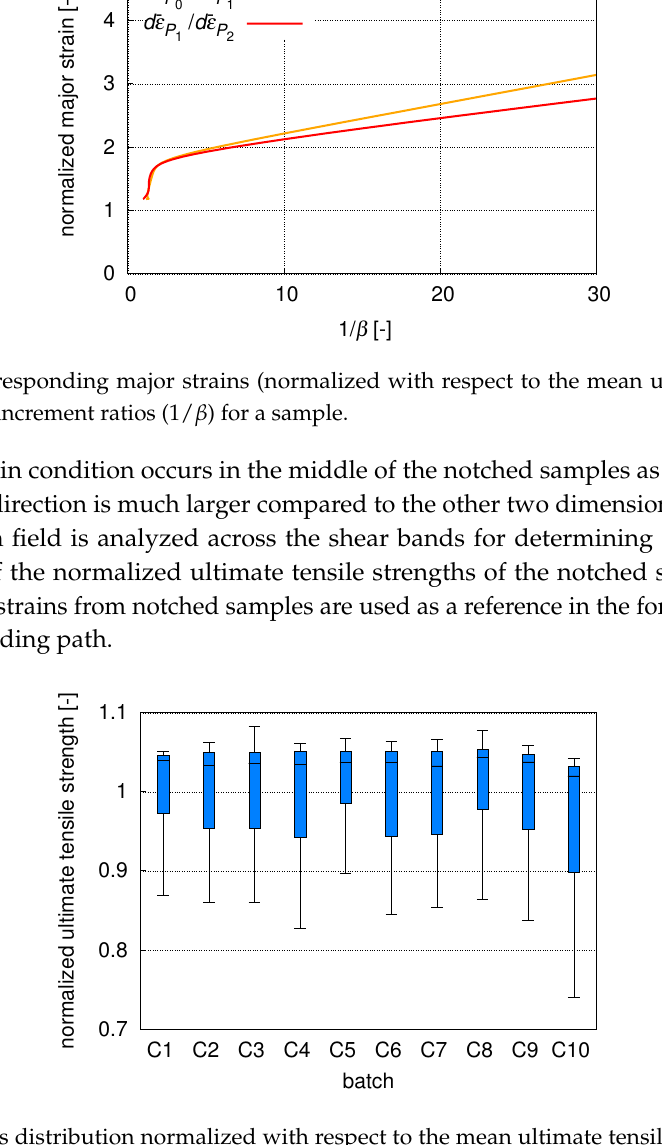
Figure 16. Stress distribution normalized with respect to the mean ultimate tensile strength ( R m ) in notched samples